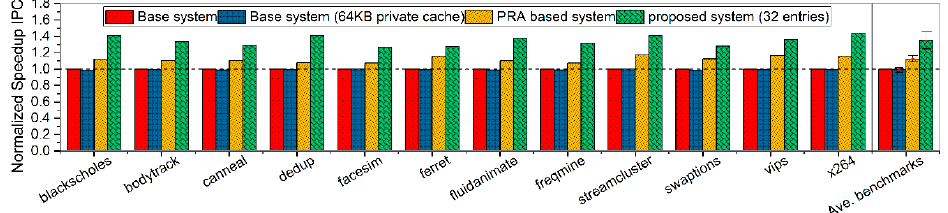
Figure 12. Normalized Speedup IPC comparisons among four methods, while our proposed system is allocated with 32 history buffer entries.